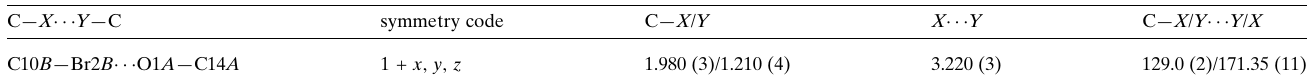
Table 3 Halogen bonds in 1